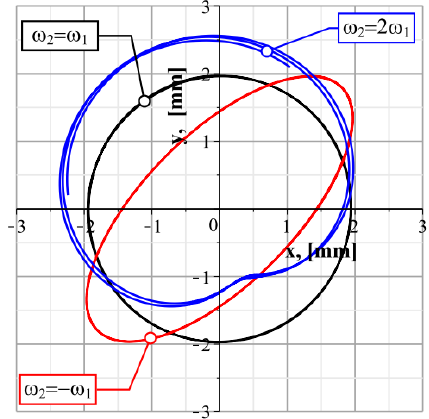
Figure 6. Trajectories of the mass center motion at different ratios between the angular speeds of the unbalanced rotors.